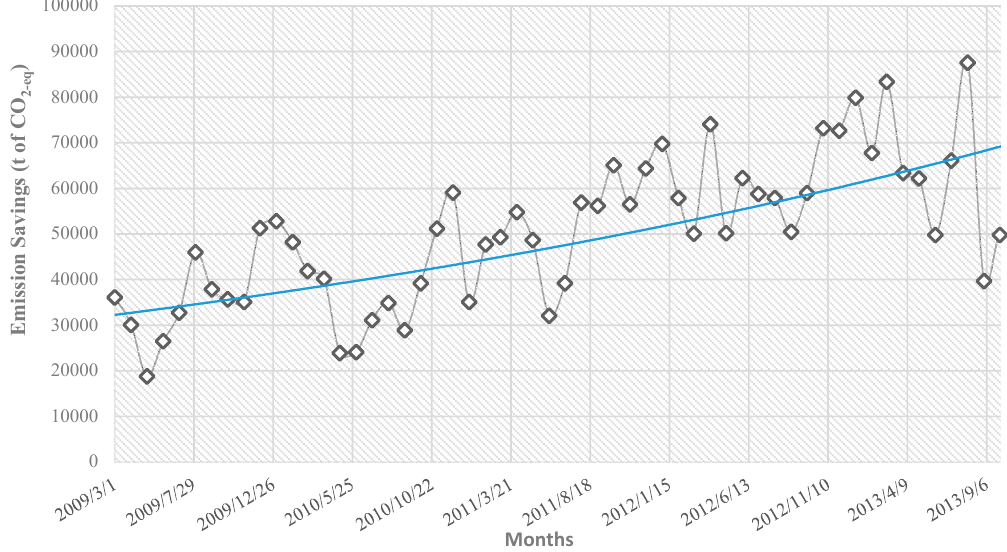
Figure 14. CO 2 emissions avoided owing to natural gas-fueled generation offset by the wind RES-E generation from FiTs in Greece during the period 2009 to 2013.